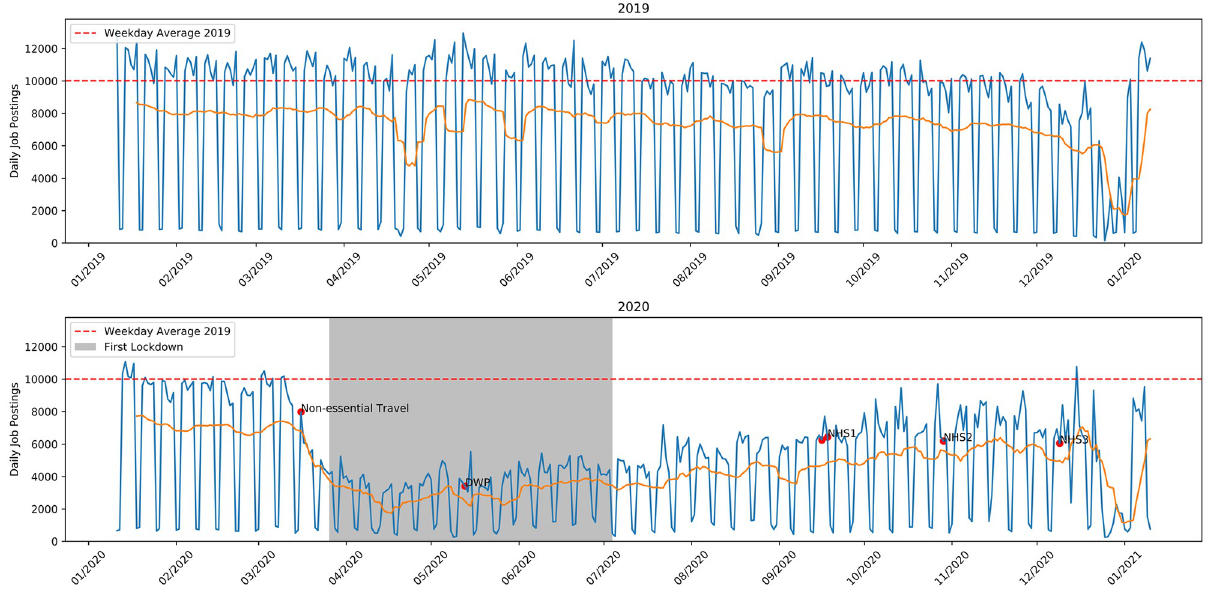
Fig 2. Daily job postings with the cross posts from the two other major job boards removed. Solid orange line is the 7 day running average count.